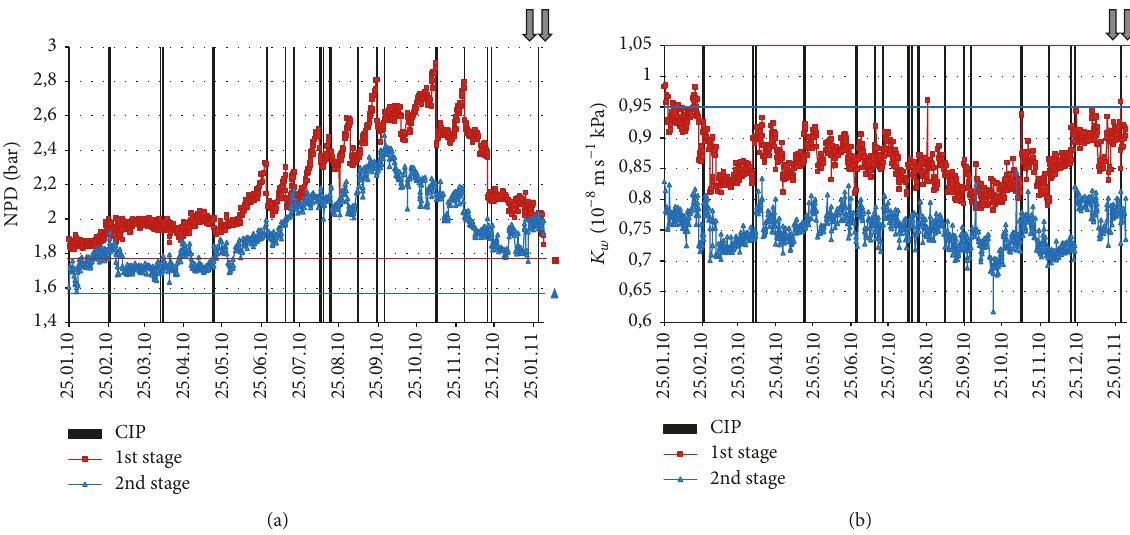
Figure 1: Key performance parameters NPD (a) and 𝐾 𝑤 (b) of plant location I. Vertical lines indicate CIP. Horizontal lines indicate performance with new membranes [day zero]. From this installation, a lead element from the first stage was taken before (25.01.2011) and directly after the last CIP indicated (02.02.2011). Time points of membrane autopsies are indicated with dark grey